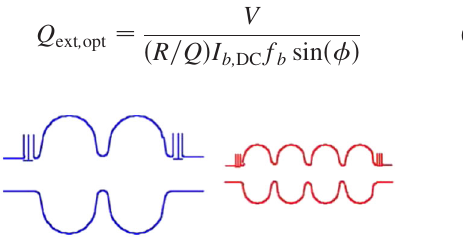
FIG. 16. (Color) Doubling of frequency and doubling of cells: cavity